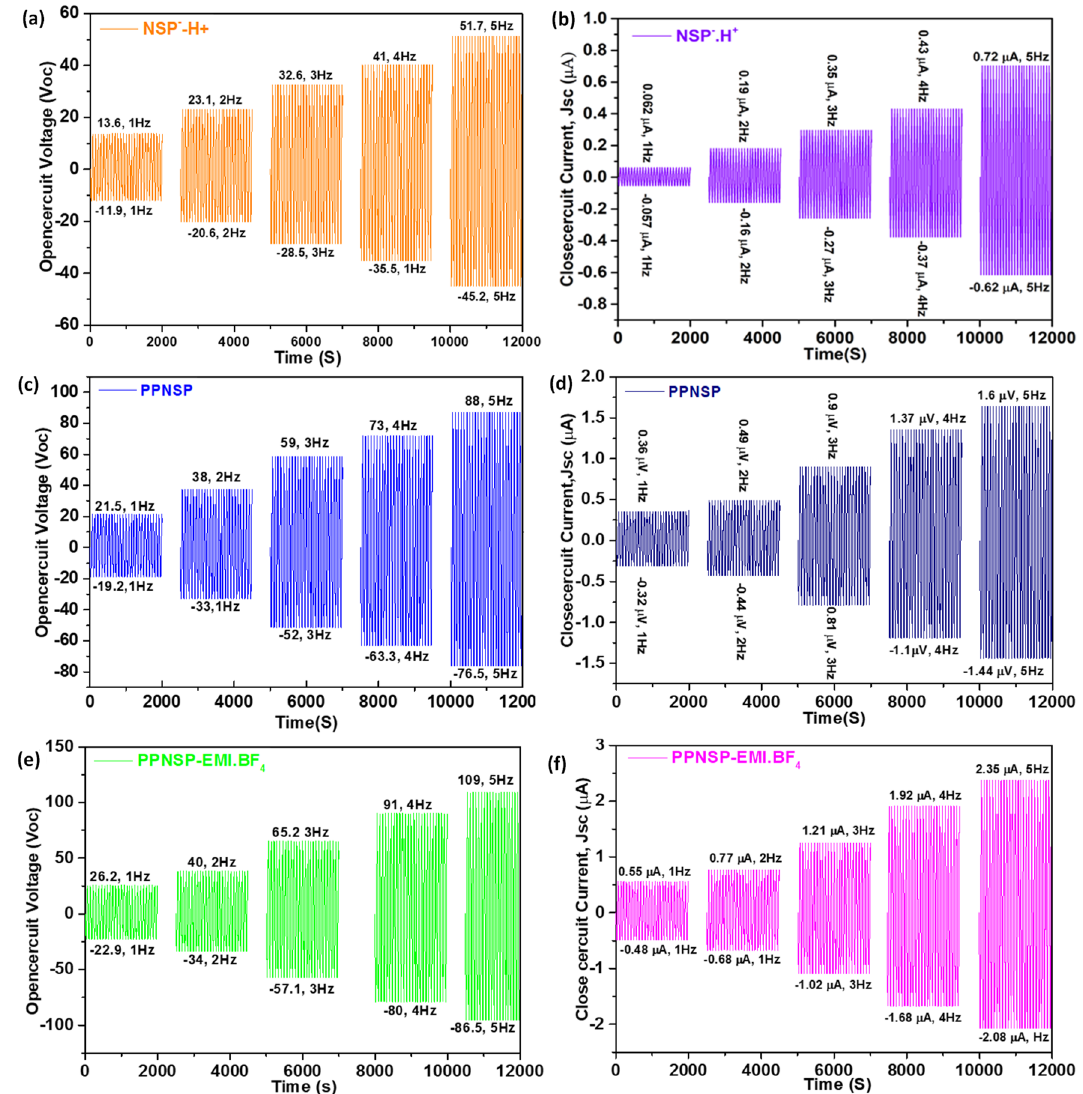
Figure 6. The output voltages (Voc) and close circuit currents (Isc) under numerous feedback conditions in open circuit structures. The Voc and Isc of ( a , b ) NSP.H + -TENG; ( c , d ) PPNSP-TENG; and ( e , f ) PPNSP-EMI. BF 4